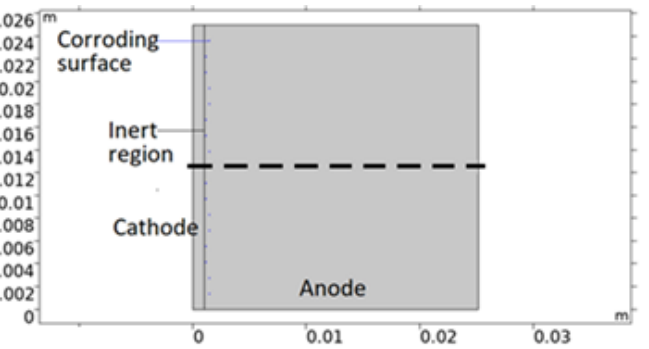
Figure 2. Illustration of a 2D model geometry representation of the calibration cell. Anode is aluminum alloy 1050, cathode stainless steel 316L, and inert region insulating anodization layer. Central dashed line roughly indicates distance and position modeled in the 1D model.